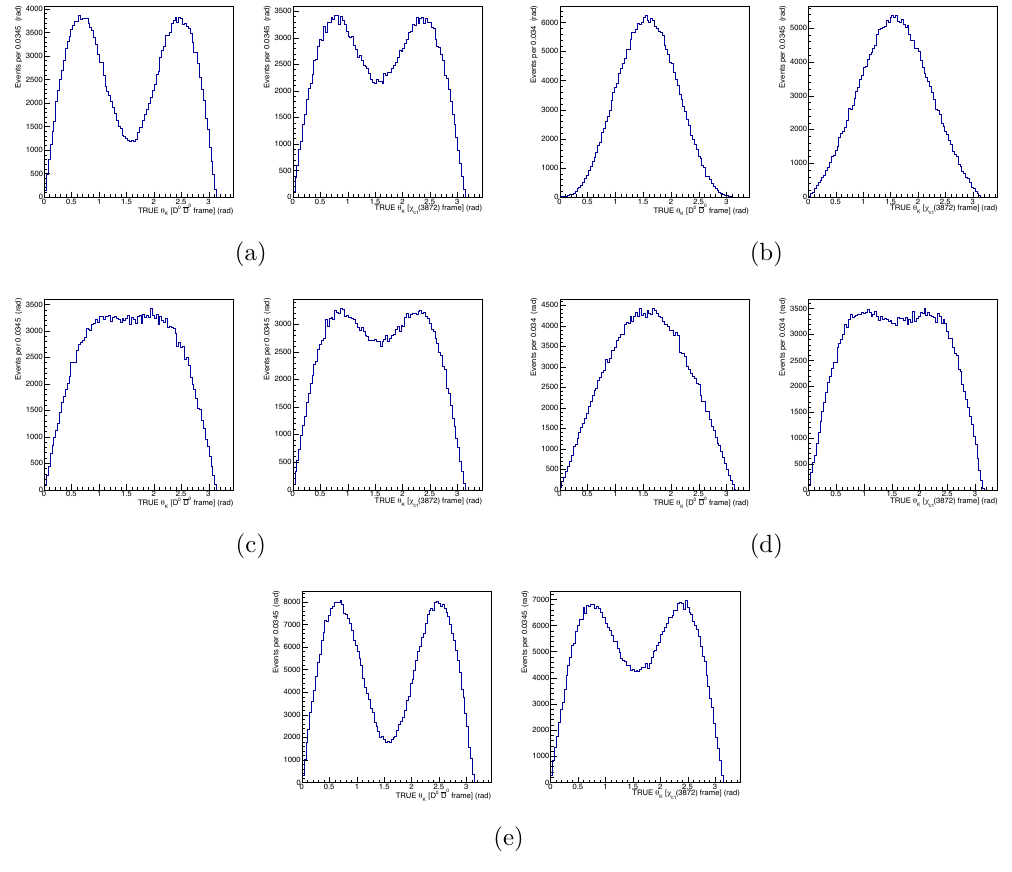
Figure 2. TRUE θ K D 0 D 0 (left) and TRUE θ Kχ c 1 (3872) (right), shown for secondary (a) χ c 1 (3872) → D 0 D 0 π 0 50/50 S-Wave only (correlation = 0.65), (b) χ c 1 (3872) → D 0 D 0 γ 50/50 S-Wave only (correlation = 0.51), (c) χ c 1 (3872) → D 0 D 0 π 0 50/50 D-Wave only (correlation = 0.65), (d) χ c 1 (3872) → D 0 D 0 γ 50/50 D-Wave only (correlation = 0.52), and (e) χ c 1 (3872) → D 0 D 0 π 0 Model (correlation =